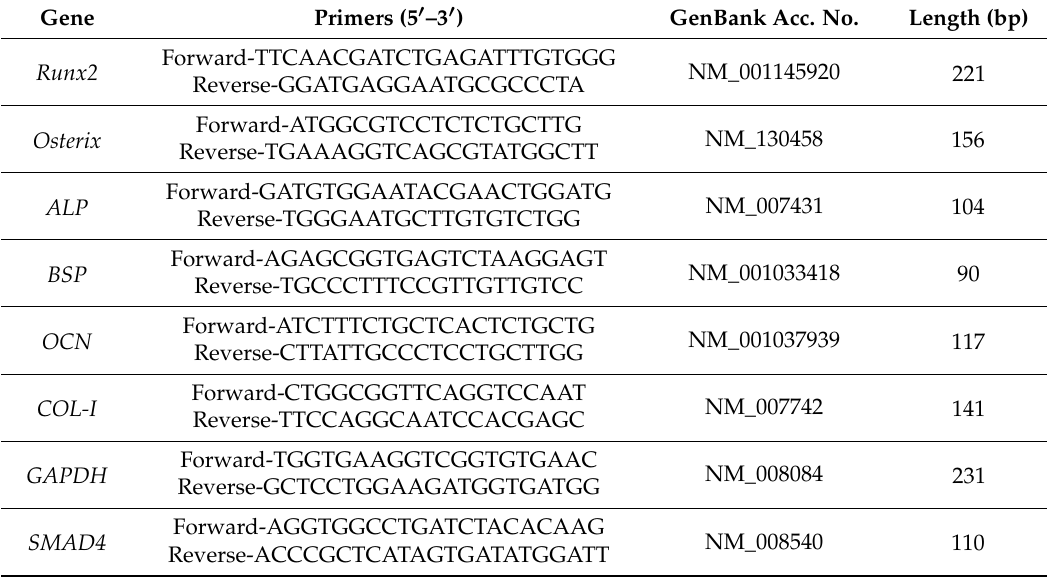
Table 3. Constructed sequences and primers used in this